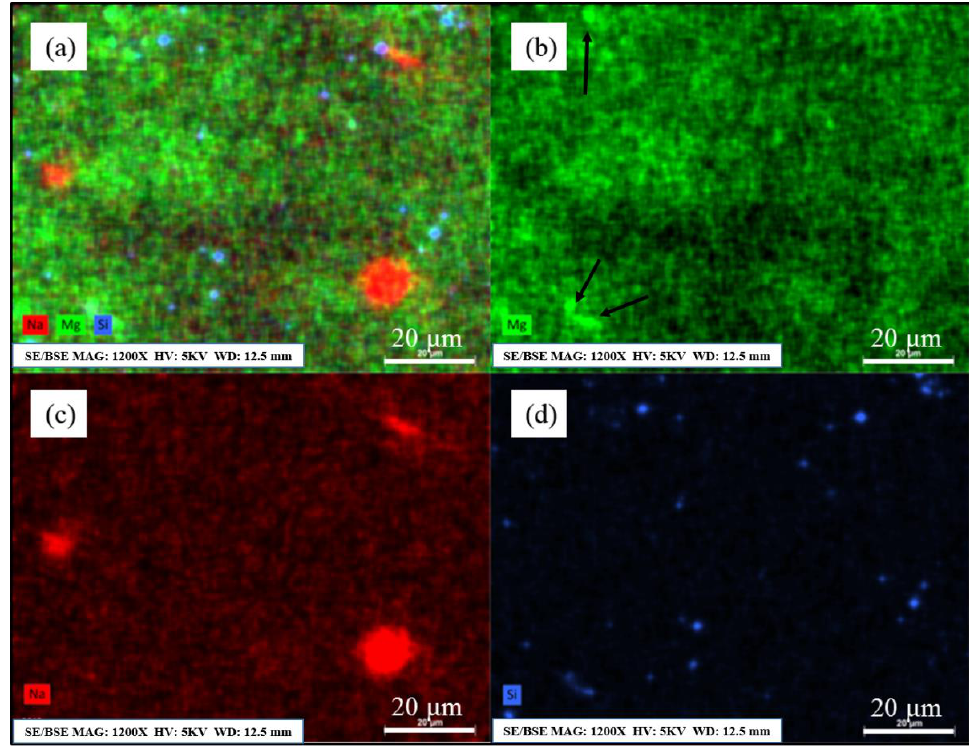
Figure 4. Elemental distribution of Na, Mg and Si in as-cast Al–2Mg alloy ( a ) Na, Mg and Si; ( b ) Mg; ( c ) Na; ( d ) Si. The solubility of Na in liquid Al was found to be 0.115 at. % at 1023 K and the maximum solubility of Na in solid Al to be less than 0.003 at. % [20]. Na will enrich in the front of the solid–liquid interface during the solidification of the alloy. When the concentration of Na in the residual liquid phase is higher than 0.115 at. %, the Na droplet will repel out of the residual liquid phase because the concentration of Na in the residual liquid phase is higher than the solubility of Na in liquid Al. Liquid sodium is immiscible with respect to liquid aluminum [20]. Due to the interfacial tension between the liquid aluminum and liquid sodium, the repelled sodium exists in the form of droplets in order to minimize the interfacial energy. Whether the sodium droplets are entrapped in the matrix depends on the size of the droplets and the growth rate of solid aluminum. The smaller the Na droplet is and the faster the solid grows, the easier it is for the droplet to attach to the solid. When the solid grows further, the Na droplet will be engulfed by the matrix. Such droplets are uniformly distributed in the matrix. During solidification the droplets are driven to preferentially collide in the residual liquid phase, and they have a large chance to coalesce and coarsen for further decrease in the interfacial energy. The big droplets